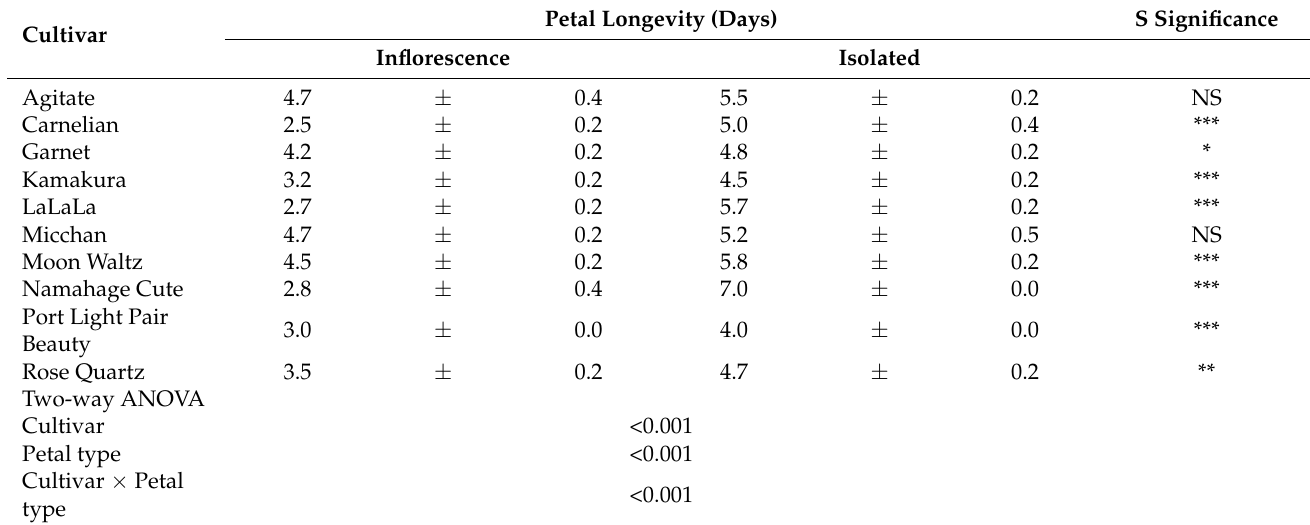
Table 1. Longevity of isolated petals in 10 dahlia